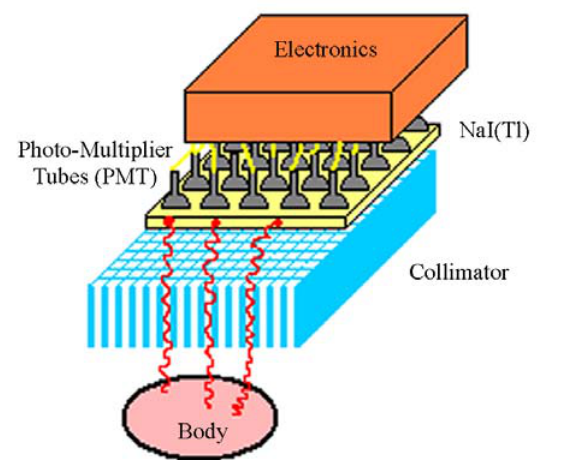
Figure 23. The typical elements of a gamma camera. Gamma rays emitted by the medical target pass through the collimator and are detected within the camera, which generates data related to the location of scintillations in the crystal as well as to the energy of the gamma rays. The scintillation light resulting from the interaction of a gamma ray in the NaI(Tl) crystal is viewed and localised by photomultiplier tubes